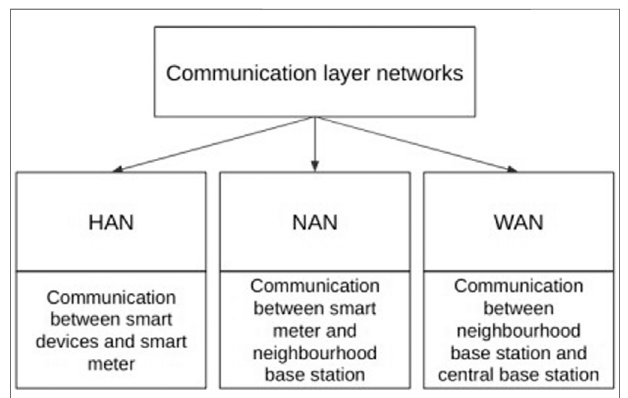
FIGURE 2 | Different communication networks in the smart